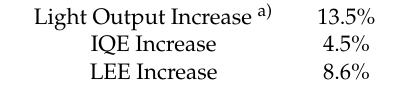
Table 2. Calculated light extraction efficiency (LEE) based on the light output data (Experimental